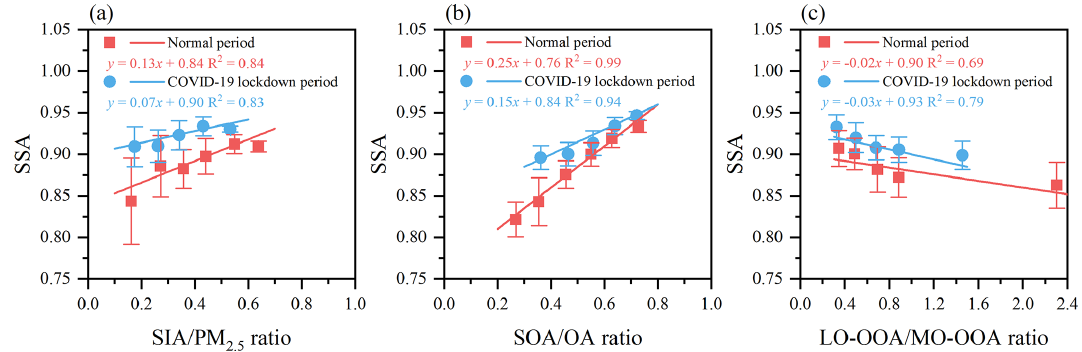
Figure 2. Variations in single-scattering albedo (SSA) as a function of (a) the secondary inorganic aerosol (SIA = NH 4 NO 3 + (NH 4 ) 2 SO 4 ) / PM 2 . 5 , (b) the secondary organic aerosol (SOA = LO-OOA + MO-OOA) / OA, and (c) the LO- OOA / MO-OOA ratios during the normal and COVID-19 lockdown periods.